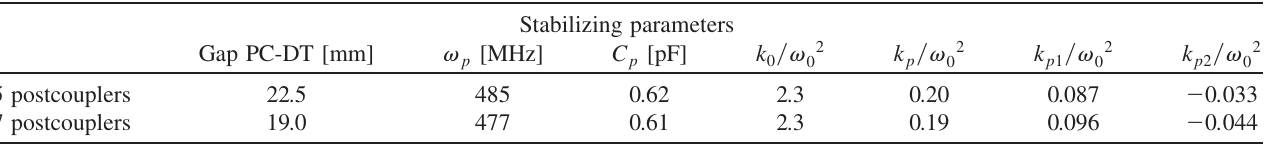
TABLE I. Stabilizing PC setting for DTL cold model equipped with 5 PCs and 7 PCs.